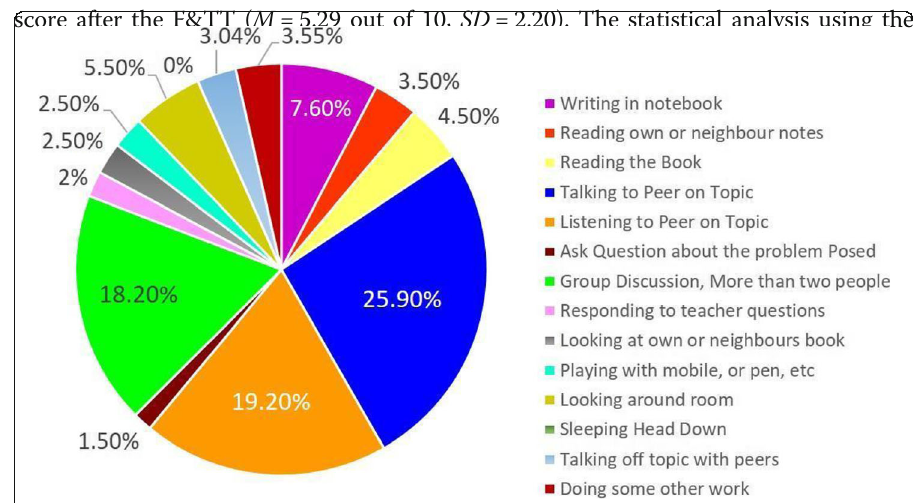
Fig. 7 Observation protocol study carried out during the pair phase of PI